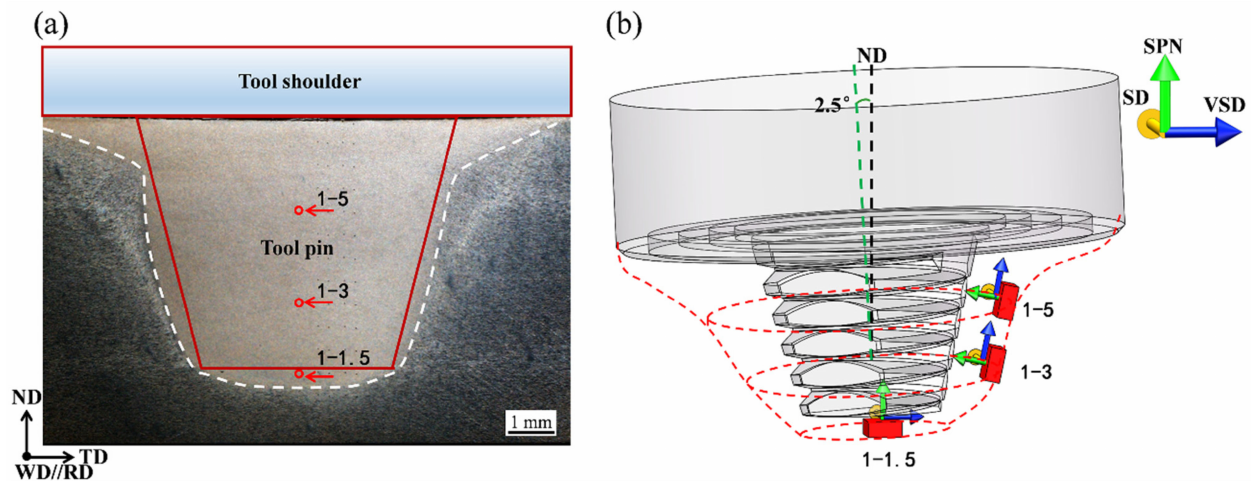
Figure 5. ( a ) Schematic of positions 1-5, 1-3, and 1-1.5 with respect to the stir tool; ( b ) shear surface of the top (position 1-5), middle (position 1-3), and bottom (position 1-1.5)